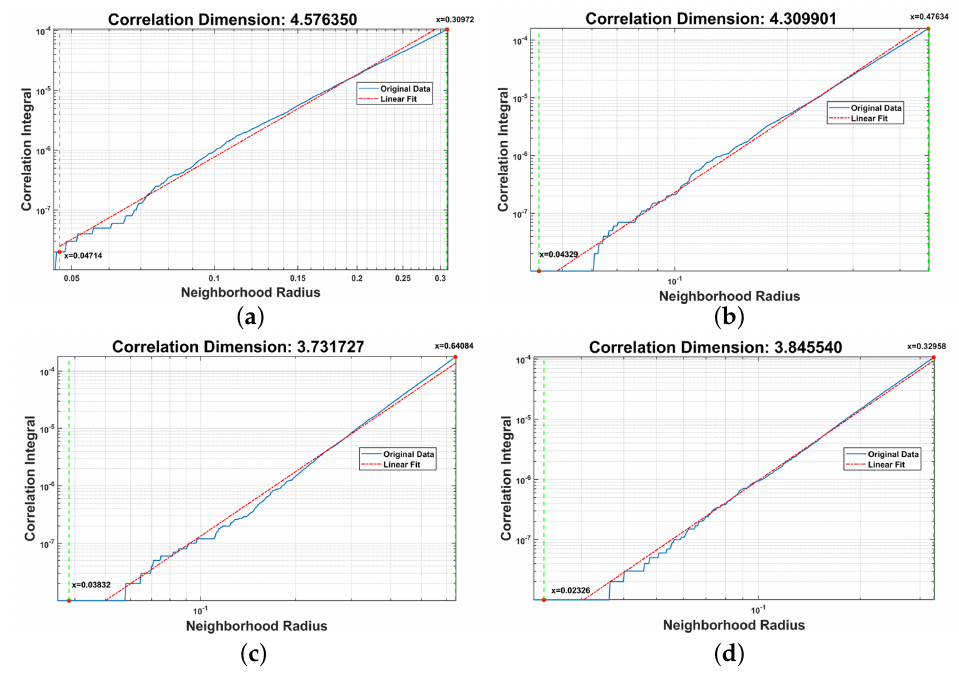
Figure 6. CD for several signals from the CP dataset. ( a ) CD for a signal from class P1, ( b ) CD for a signal from class P6, ( c ) CD for a signal from class P10, ( d ) CD for a signal from class